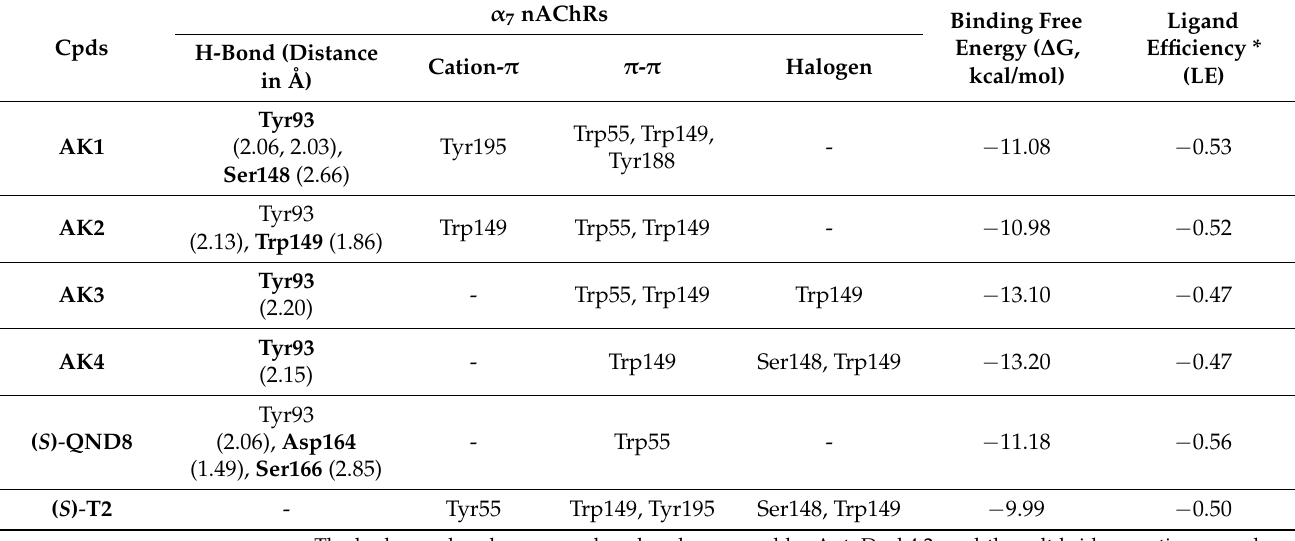
Figure 7. The binding interactions of ( a ) AK2 and ( b ) AK4 to α 7 nAChR. A and B indicated principal and complementary subunits, respectively. Table 3. The amino acid residues involved in the binding interaction to α 7